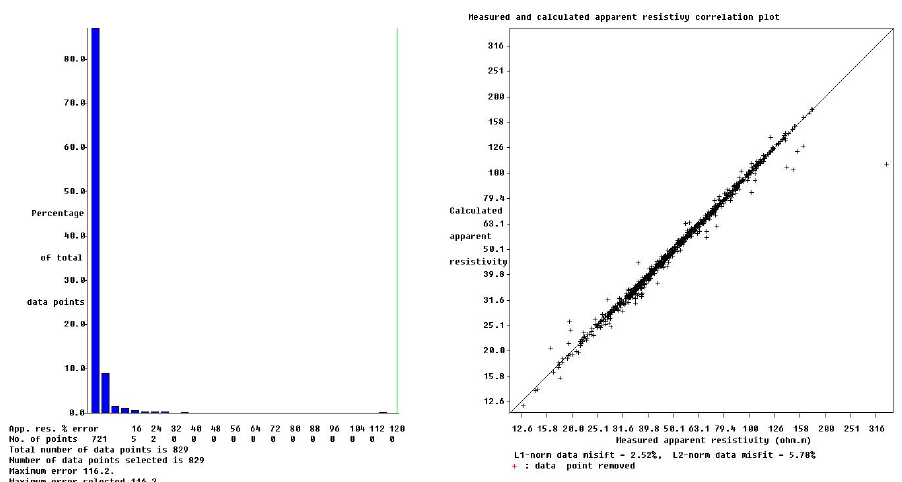
ent resistivity distribution measured with the Wenner–Schlumberger array.